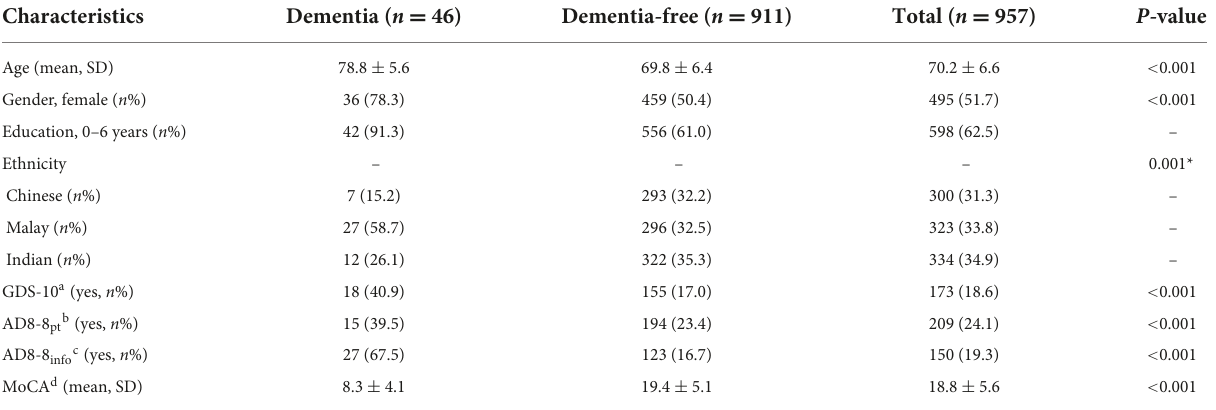
TABLE 1 Sample characteristics at Phase II.